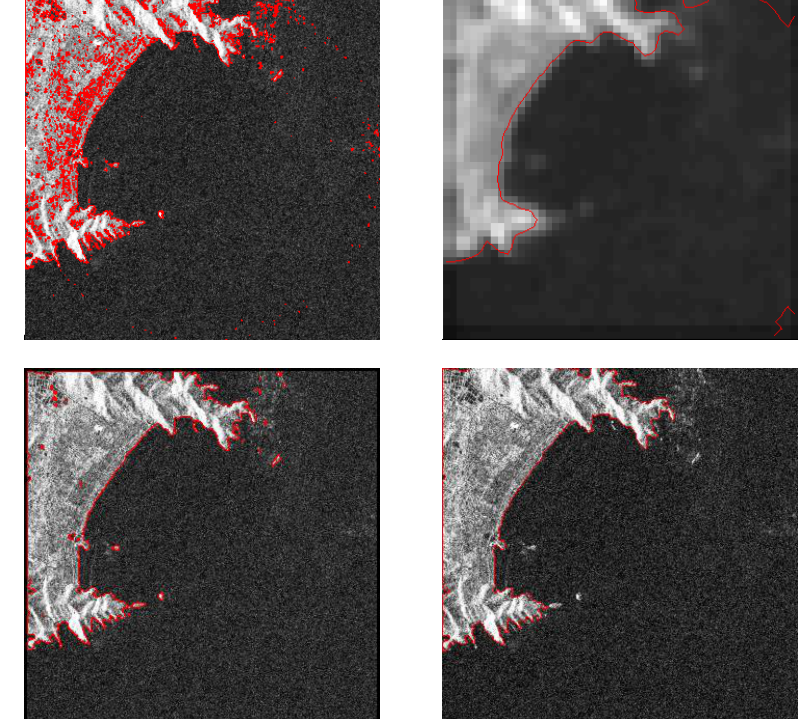
Figure 2. The coastline segmentation results of SAR image: (a) ordinary C-V model result, (b) low scale image sequence result, (c) exponential multi-scale C-V model result, (d) automated coastline segmentation result